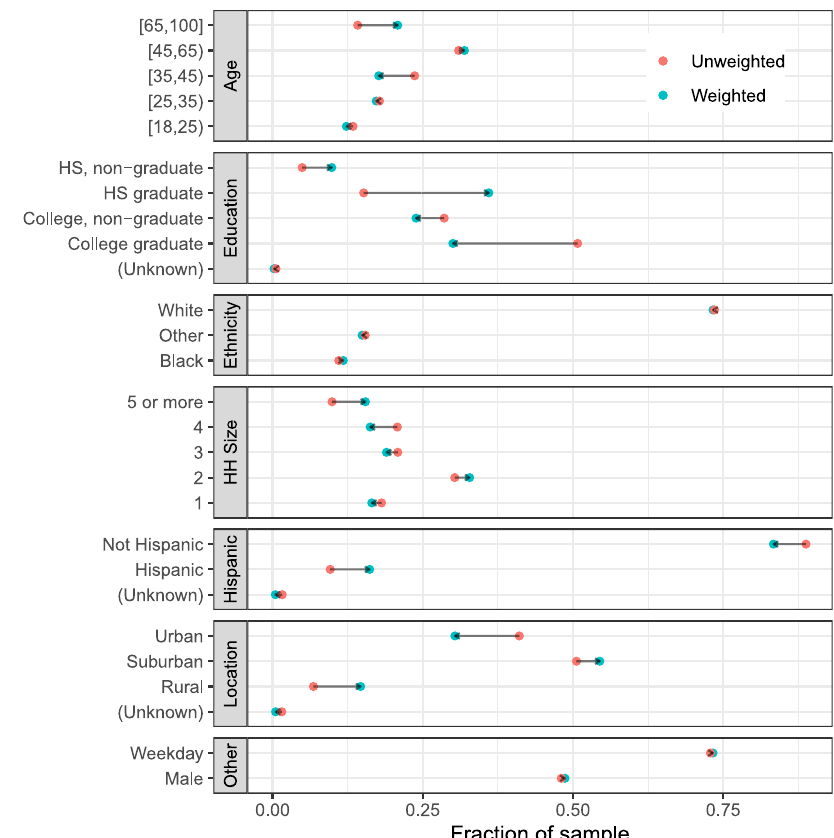
Fig. 5 Characteristics of survey respondents. We use calibration weights to improve the representativeness of our sample. Each facet shows the unweighted (red) and calibration weighted (blue) composition of survey respondents for a given